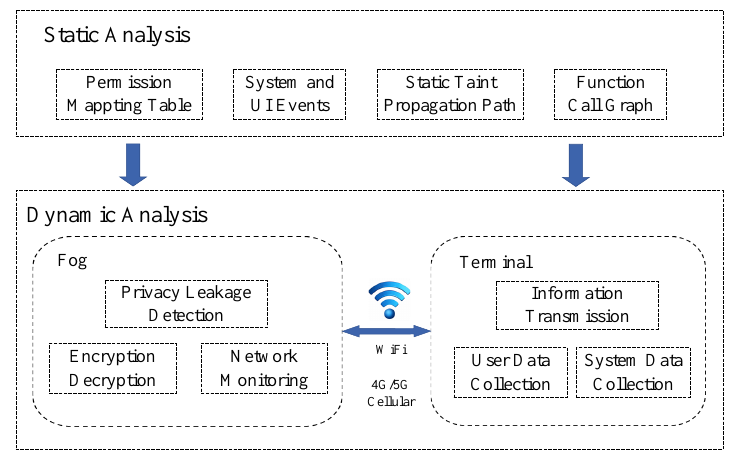
Figure 4. Framework of privacy leakage